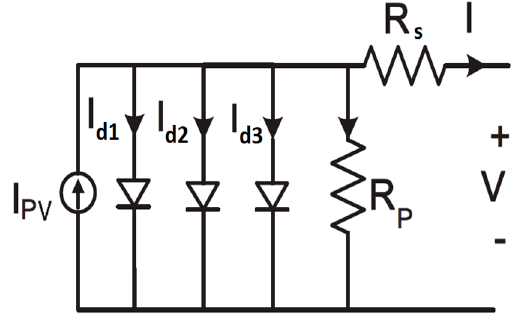
Figure 1. Three diode Photovoltaic (PV) model.